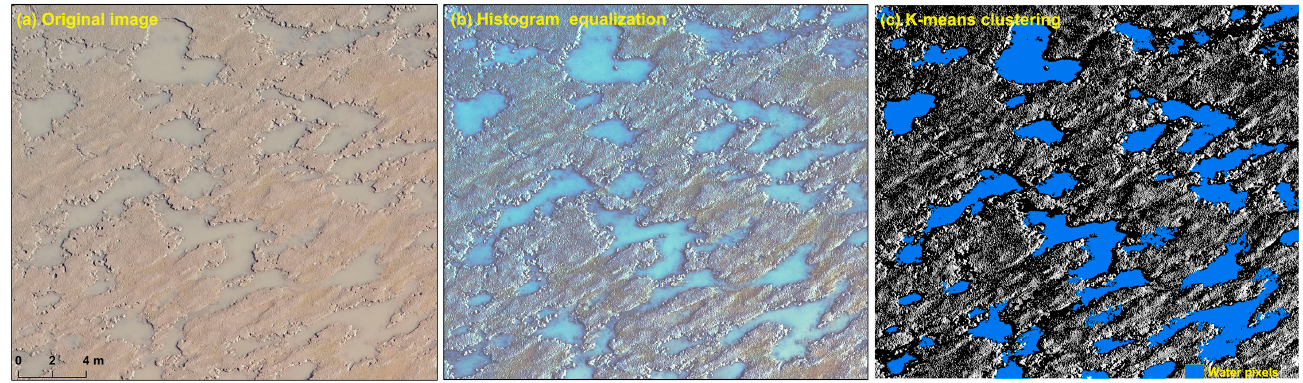
Figure 4. Identification of surface water areas using histogram equalization and K-means clustering.